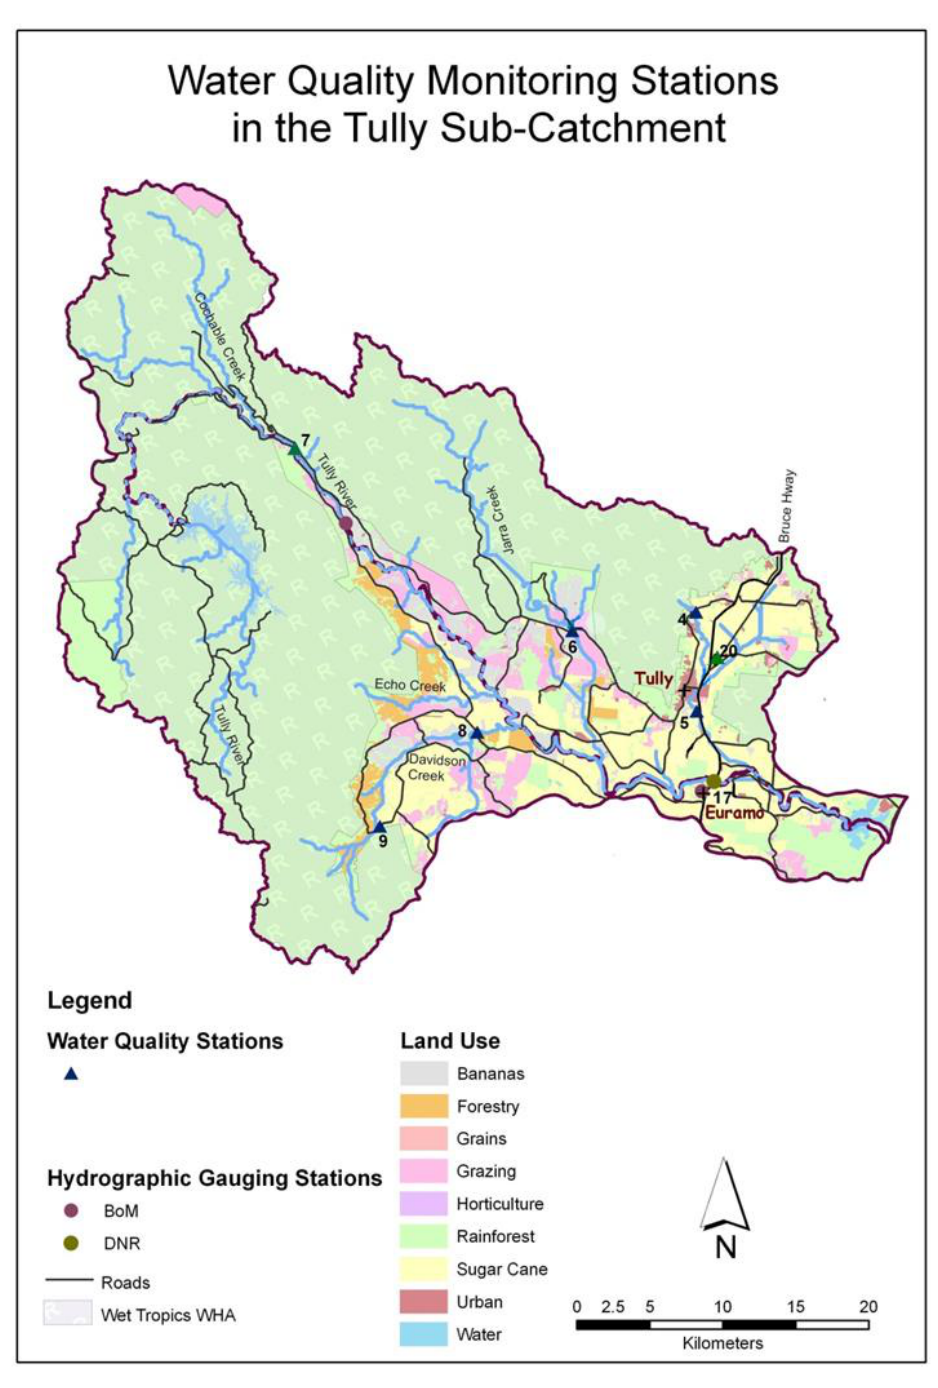
Figure A3. Water quality sampling station locations in the Tully subcatchment.